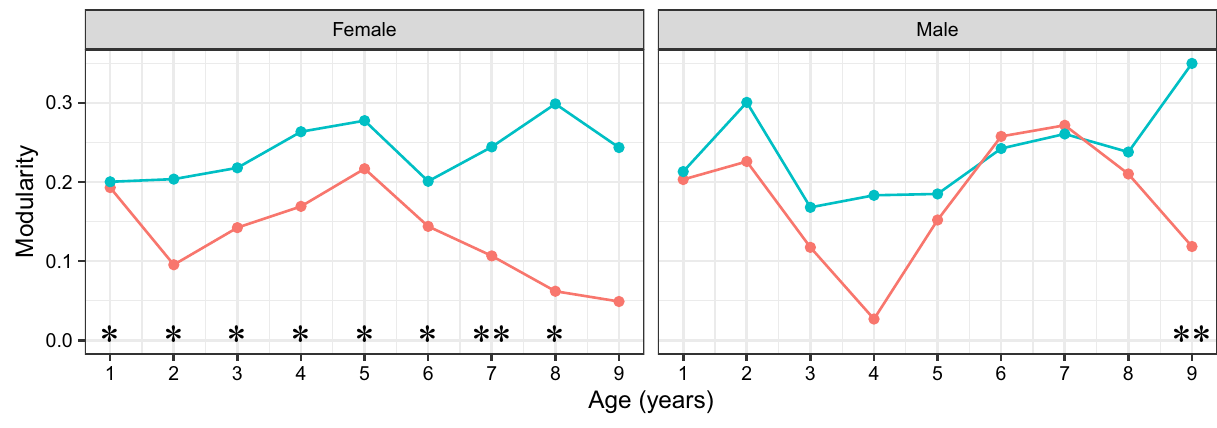
Figure 2. Modularity of SCNs at ages 1–9 for the four groups divided by sex and maternal education. Significance of differences is indicated separately for each comparison (*0.05, **0.01).